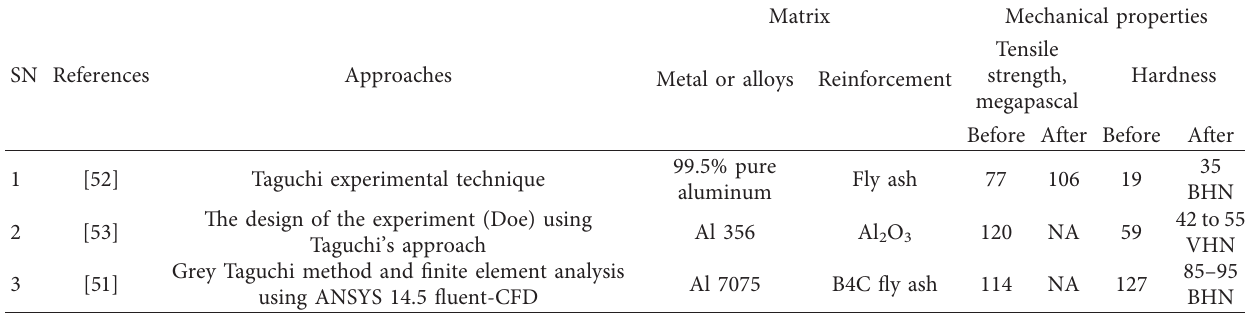
Table 5: Summarized literature reviews of statistical and numerical